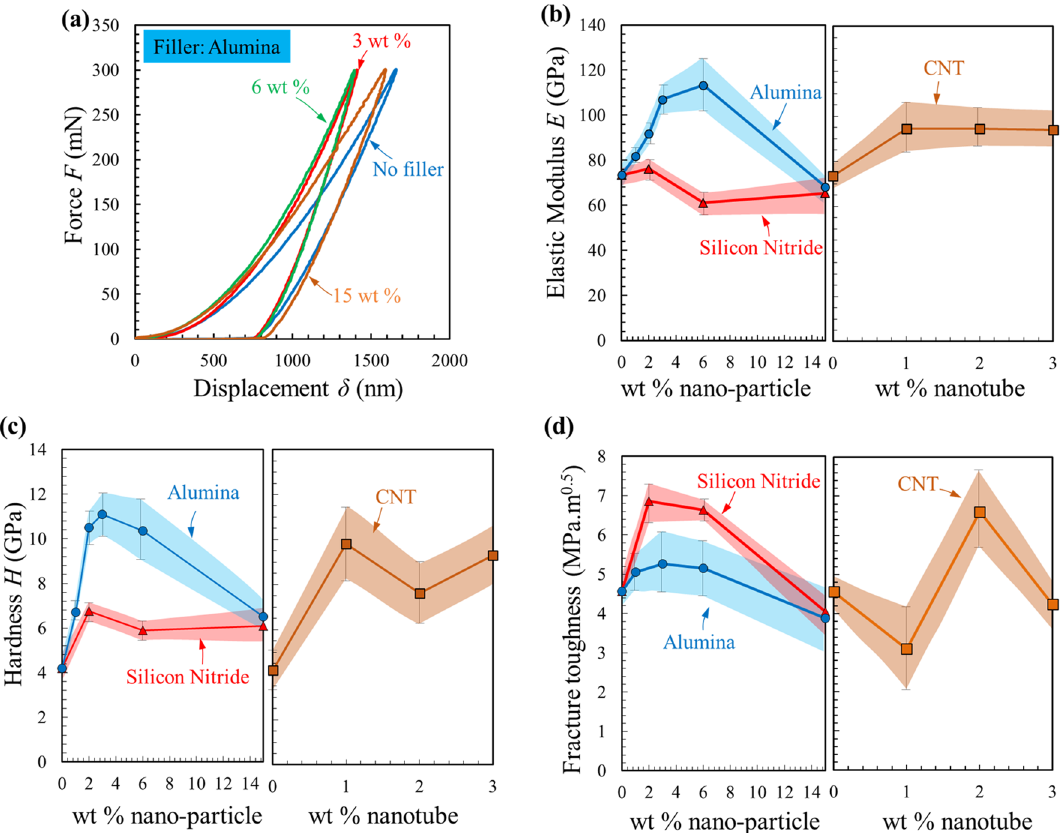
Figure 2. Properties of the modified PDCs obtained from nano/micro-indentation. ( a ) Representative nano- indentation force–displacement results for the samples containing alumina nano-filler. ( b ) Elastic Modulus, ( c